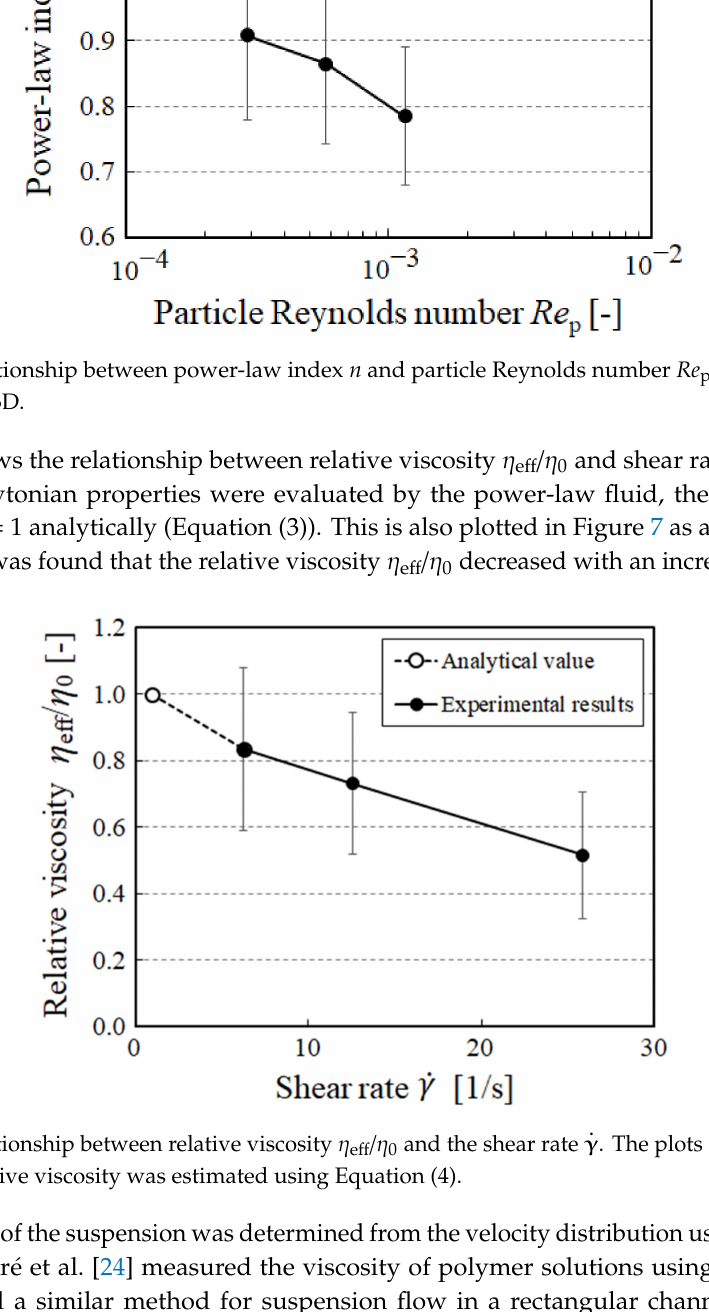
Figure 7. Relationship between relative viscosity η e ff / η 0 and the shear rate 1 SD. The relative viscosity was estimated using Equation